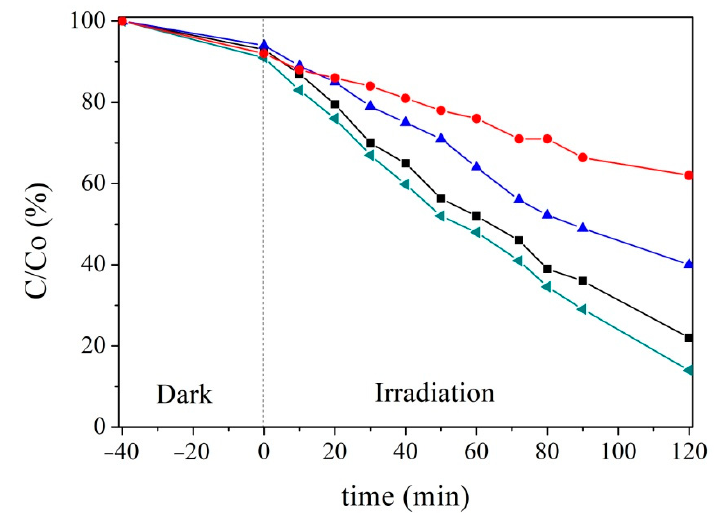
Figure 9. Decoloration of MB in the presence of ZT-rGO at 2 wt % rGO without scavenger ( ◀ ) and in the presence of 2,2,6,6-Tetramethylpiperidin-1-yl)oxyl (TEMPO) ( ● ), ethylenediaminetetraacetic acid (EDTA) ( ◼ ), and tert- butanol ( ▲ ) at 1.0 mM.